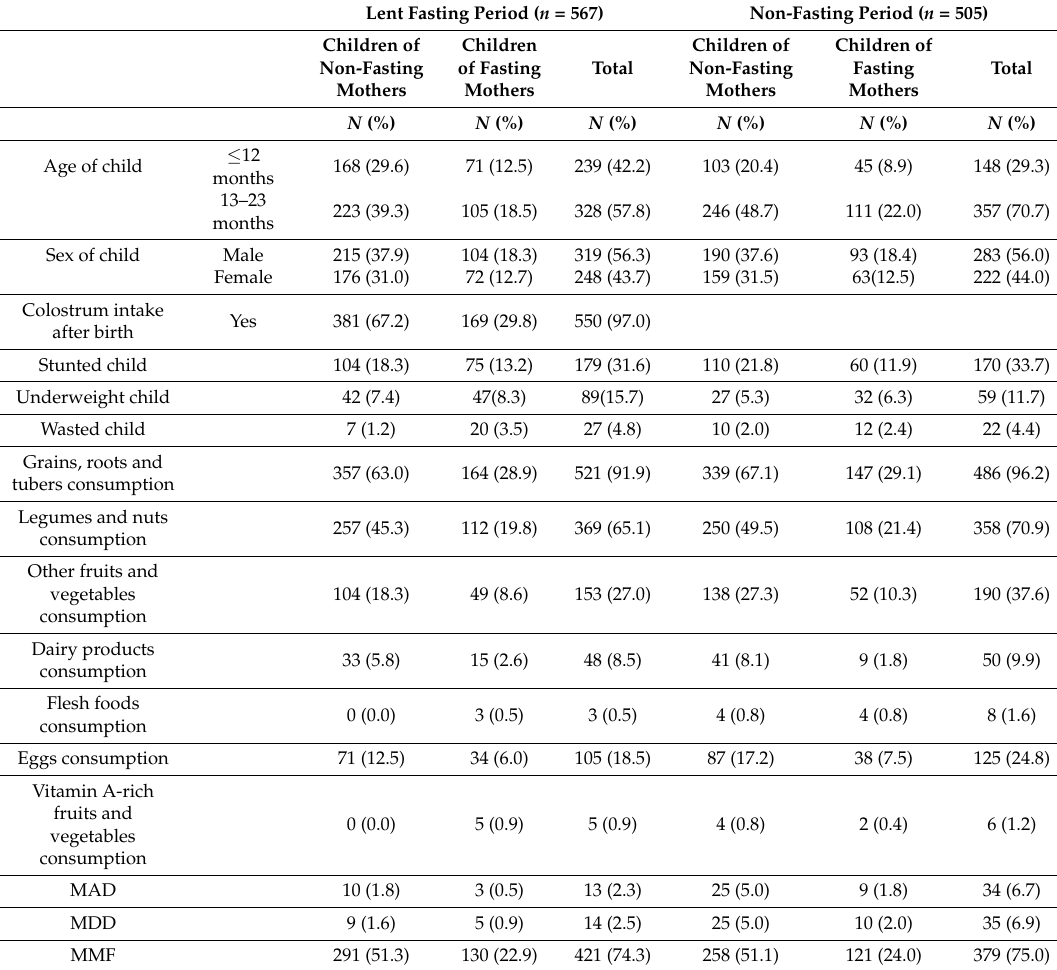
Table 2. Basic information, anthropometric status and consumption pattern of 6–23-month-old children in lent fasting and non-fasting periods in rural Tigray, Ethiopia (February–June, 2017). Lent Fasting Period ( n = 567) Non-Fasting Period ( n =